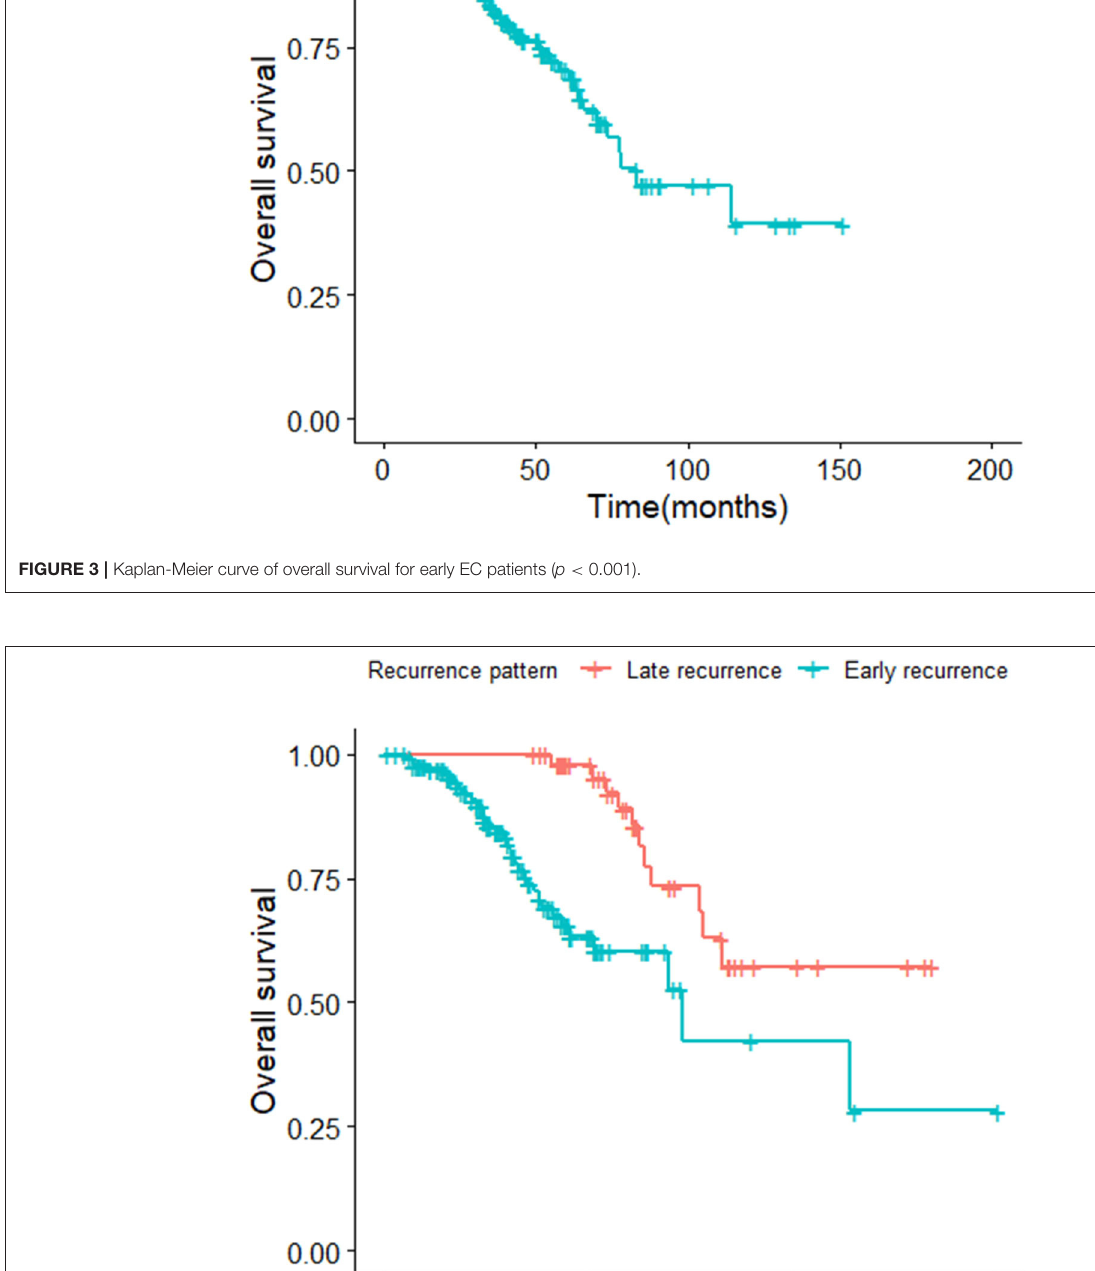
Frontiers in Medicine |